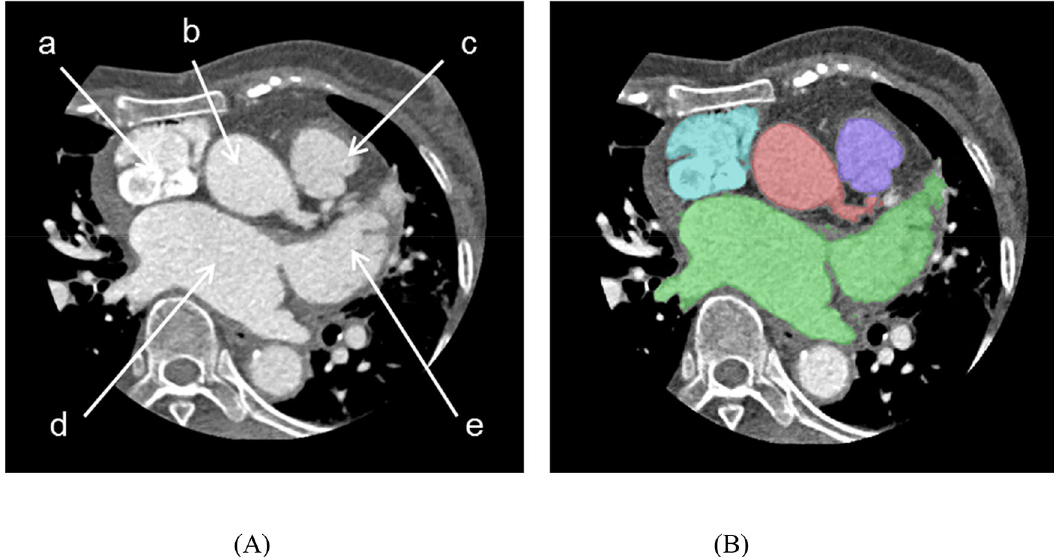
Figure 2. Segmentation based on cardiac anatomy by cardiac CT angiography, including: ( A ) CT image based cardiac anatomy: ( a ) cavoatrial junction, ( b ) ascending aorta, ( c ) main pulmonary artery, ( d ) left atrium, ( e ) left atrial appendage; and ( B ) Segmentation based on CT angiography. CT computed tomography (Spectral 3, Filter B, Philips, Best, The Netherlands).